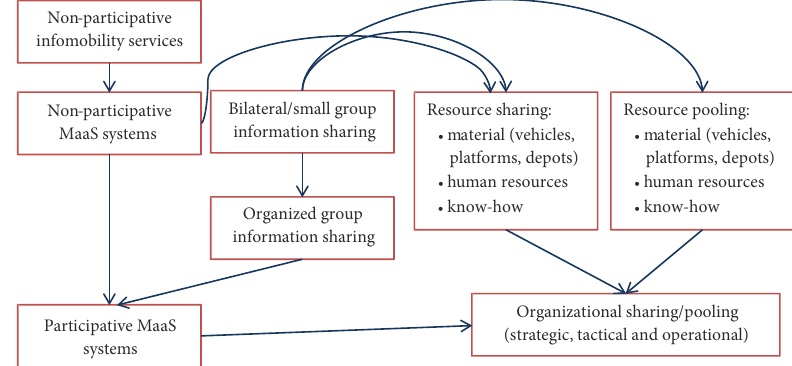
Figure 4. The different degrees of maturity in informational and decisional